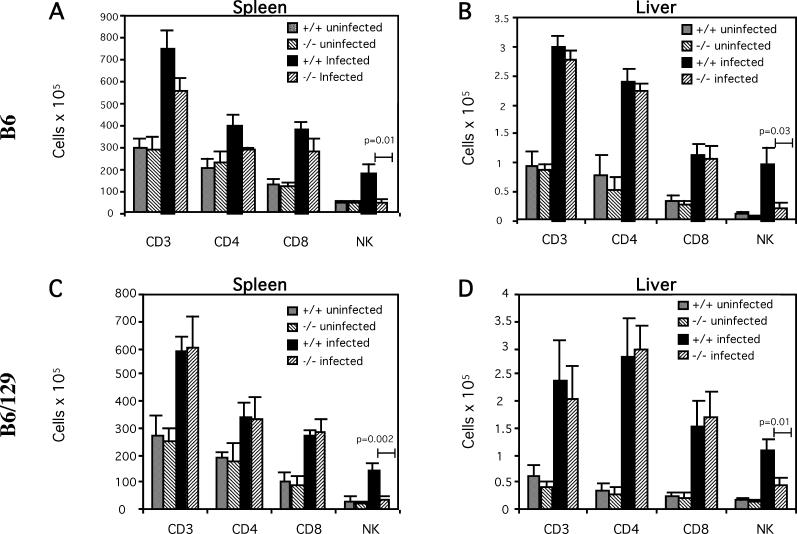
T Cell and NK Cell Numbers in the Spleen and Liver of T. gondii-Infected CCR5−/− and CCR5+/+ Mice in the C57BL/6 and C57BL/6x129 BackgroundsCell numbers. T cell and NK cell numbers in spleen (A and C) and liver (B and D) of mice infected with 15 cysts and harvested 7 d PI. Single-cell suspensions of spleen and hepatic lymphocytes were prepared and phenotyped for the expression of CD3, CD4, CD8, and NK1.1 by FACS analysis. The experiment was performed twice with similar results (three or four mice per group).